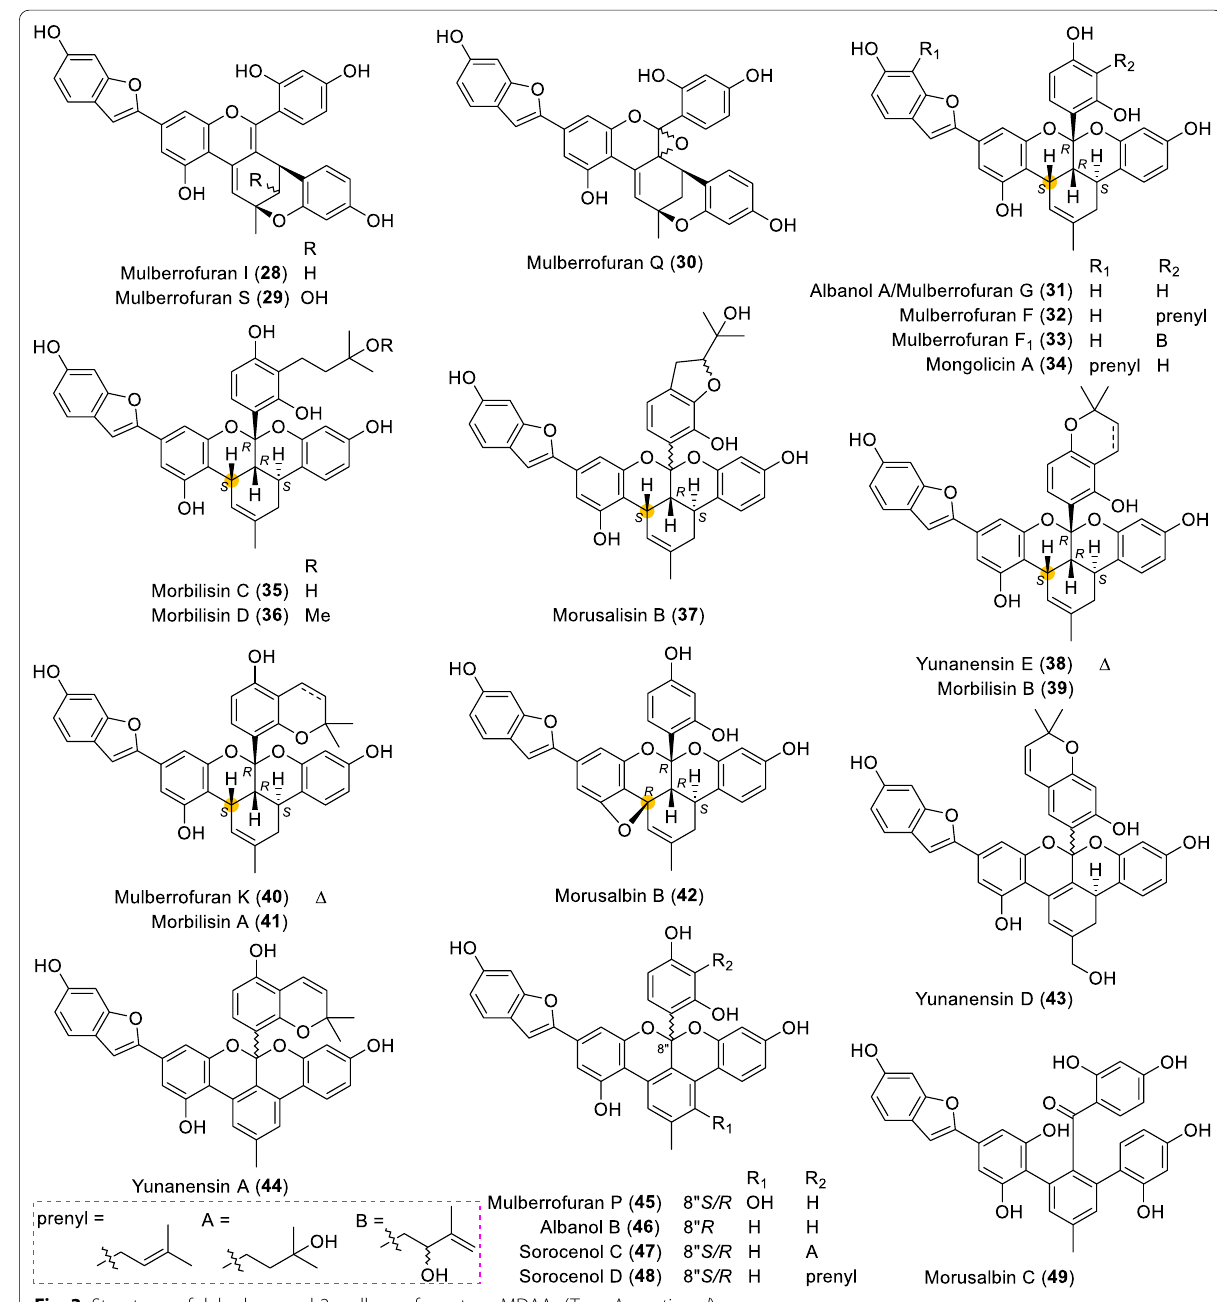
Fig. 3 Structures of dehydroprenyl‑2‑arylbenzofuran type MDAAs (Type A, continued